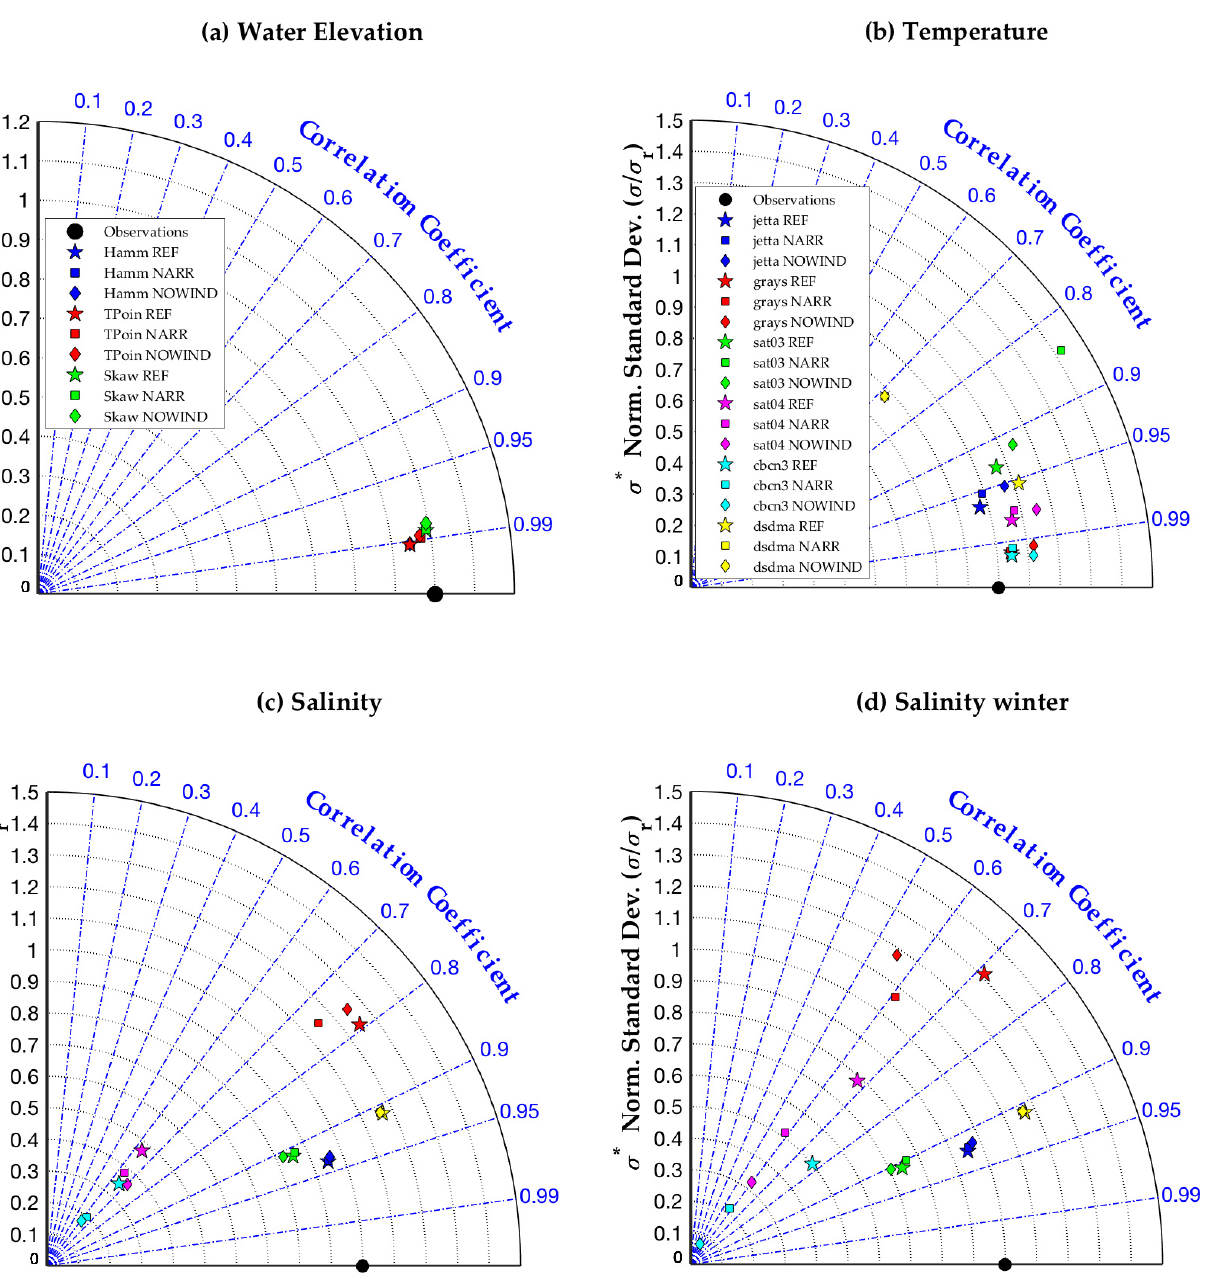
Figure 2. Taylor diagram plots of the three simulations REF, NARR, and NOWIND. ( a ) Water elevation, full year 2014. Results for the Hammond station (in blue) are almost overlapping and are covered by the red star symbol of Tongue Point station (TPoin); ( b ) near bottom temperature, full year 2014; ( c ) near bottom salinity, the full year 2014; ( d ) near bottom salinity for the winter period only. Winter represents the months of January, February, November, and December. The legend for ( c ) Salinity and ( d ) Salinity winter is the same as in ( b ) Temperature.